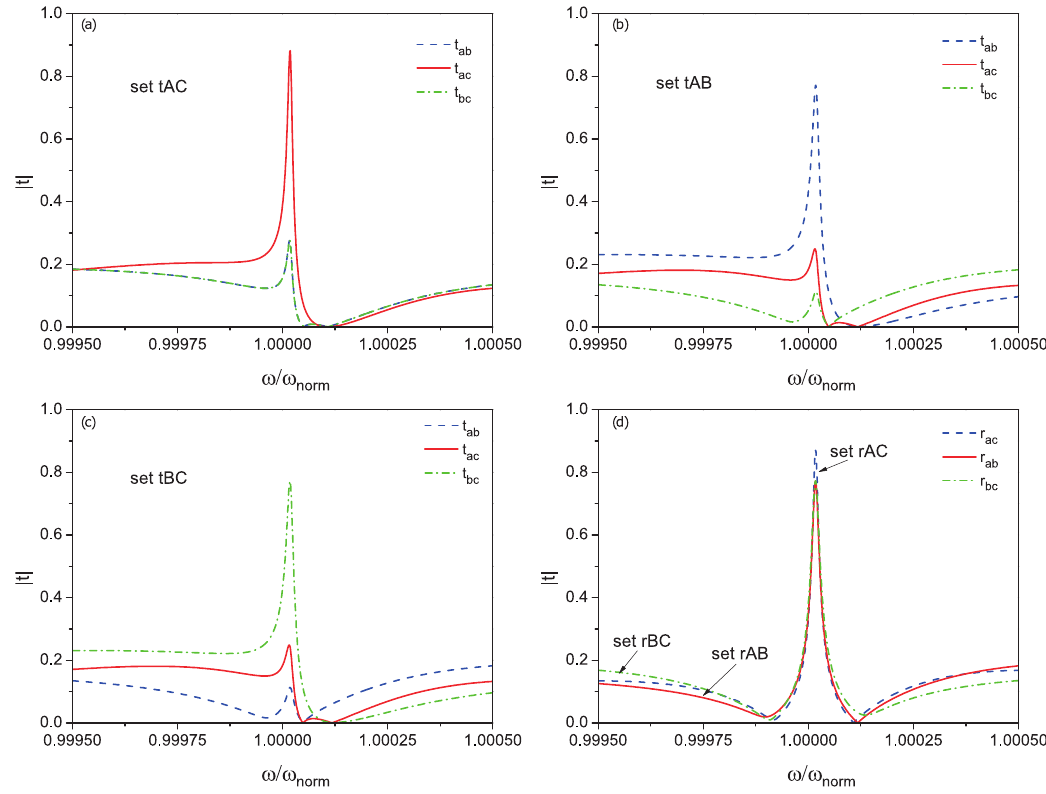
Figure 3. The six-port device’s tunability of routing by setting qubits’ excitations frequencies (set fIJ refers to combinations of to provide maximum transmission (f = t) or reflection coefficients (f = r) between waveguides I and J ( I , J = A , B , C ). Tranmission ( a – c ) and reflection ( d ) coefficients dependencies are shown. Parameters are the following: β = 0.2, L side = π /30, L 12 = 0.01 π , Θ N is set to 5 GHz , Γ central = 10 MHz. The sets are described in Table 2.